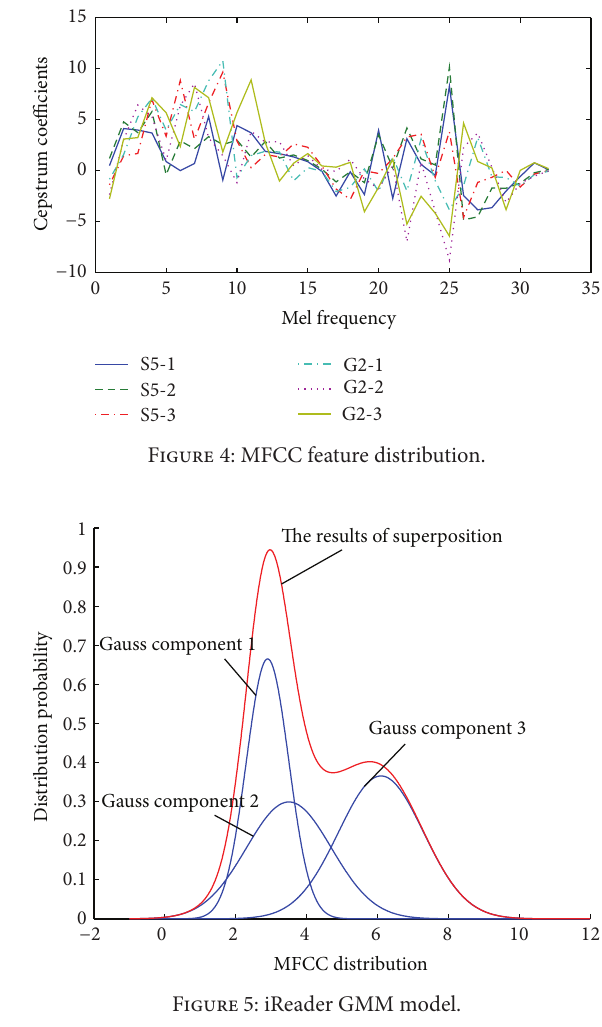
Figure 5: iReader GMM